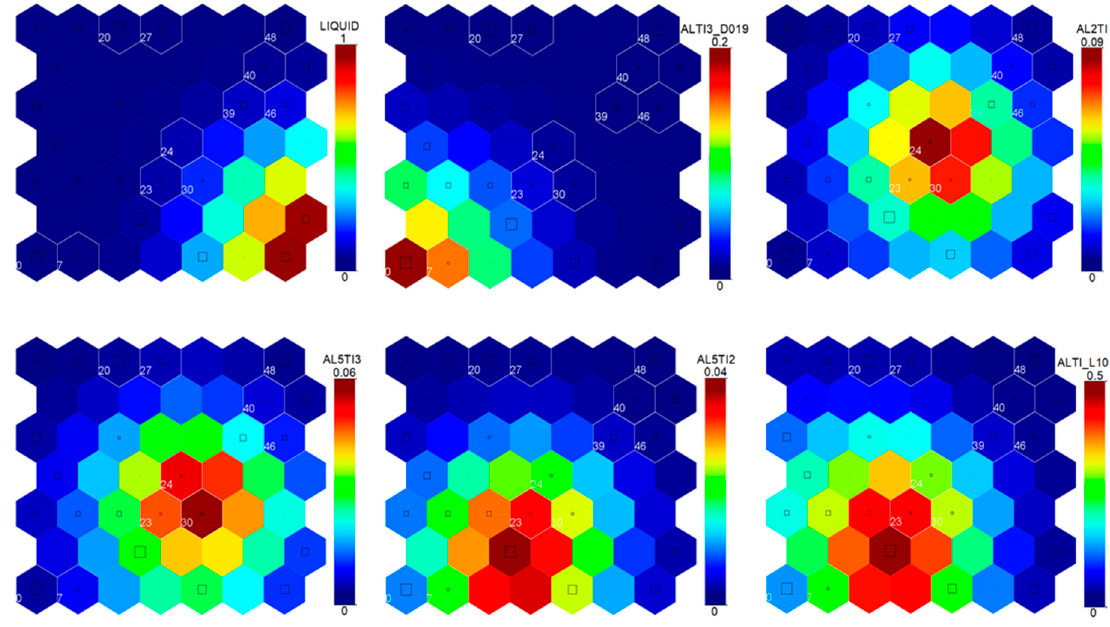
Figure 3. Phases that are not desired in the present system.